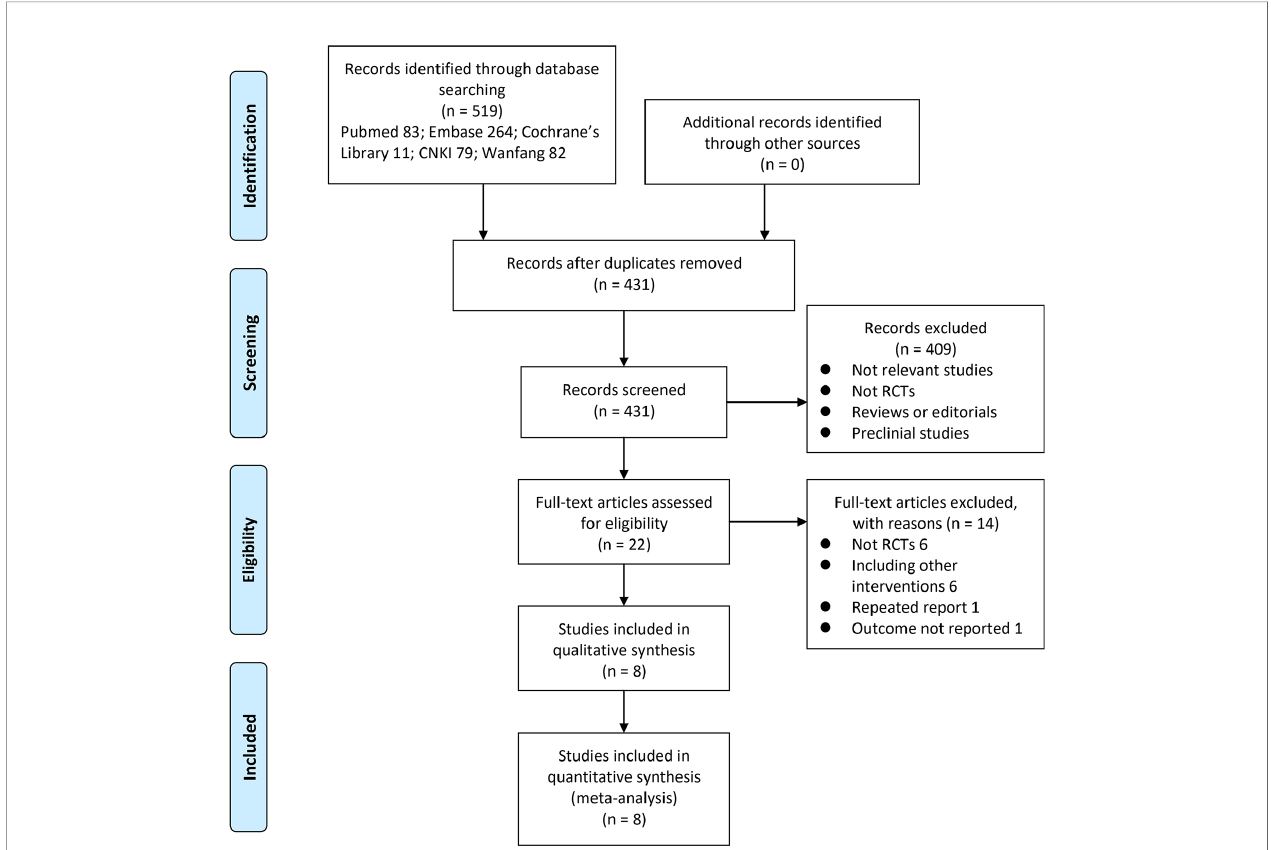
FIGURE 1 | Flowchart of database search and study identi fi